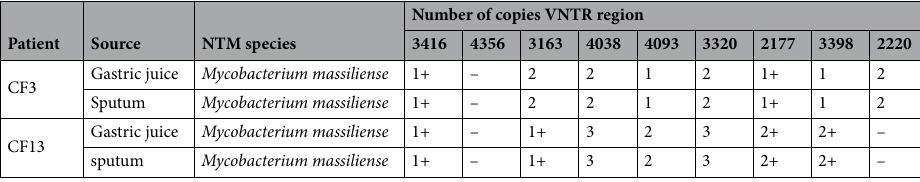
Table 4. VNTR profile for NTM species isolated form gastric juice and sputum sample of patient 3 and 13.